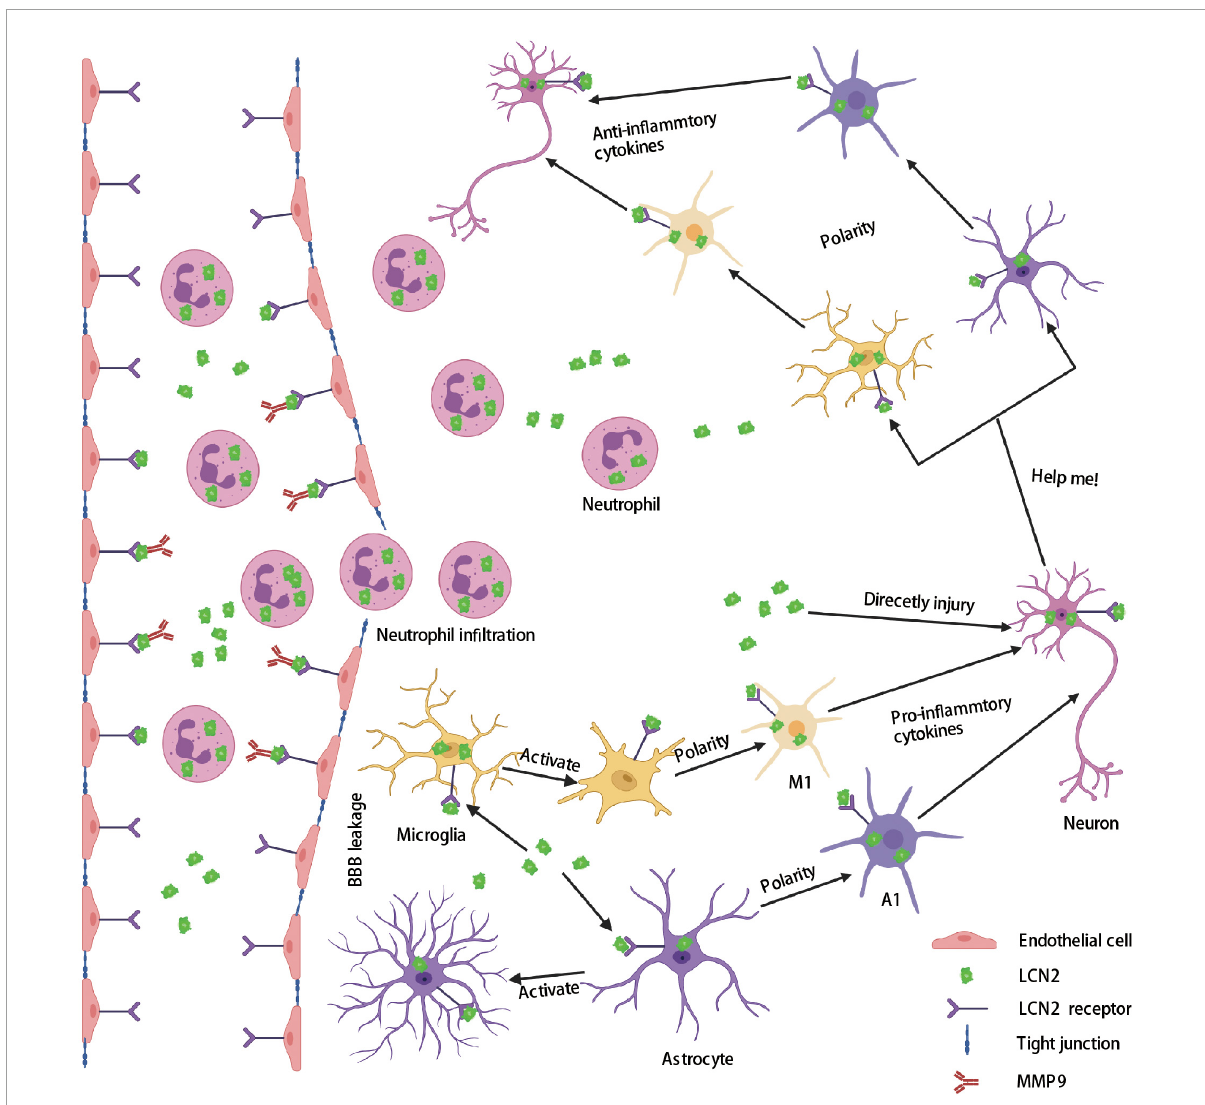
FIGURE4 Role of LCN2 in the brain after stroke. Firstly, a large amount of LCN2 was up-regulated both in the peripheral blood and brain after stroke. Secondly, LCN2 activates MMP9 and forms a complex that binds to endothelial cells through the LCN2 receptor, and then destroys tight junctions to form BBB leakage. Thirdly, neutrophils enter the brain through BBB leakage. The highly expressed LCN2 in the brain activates microglia and astrocytes and polarizes them into a proinflammatory phenotype (M1 and A1), which directly or indirectly injury neurons. Lastly, damaged neurons release LCN2 as a help-me signal and polarizes microglia and astrocytes into an anti-inflammatory phenotype (M2 and A2). BBB, blood–brain barrier; LCN2, lipocalin 2; MMP9, matrix metallopeptidase